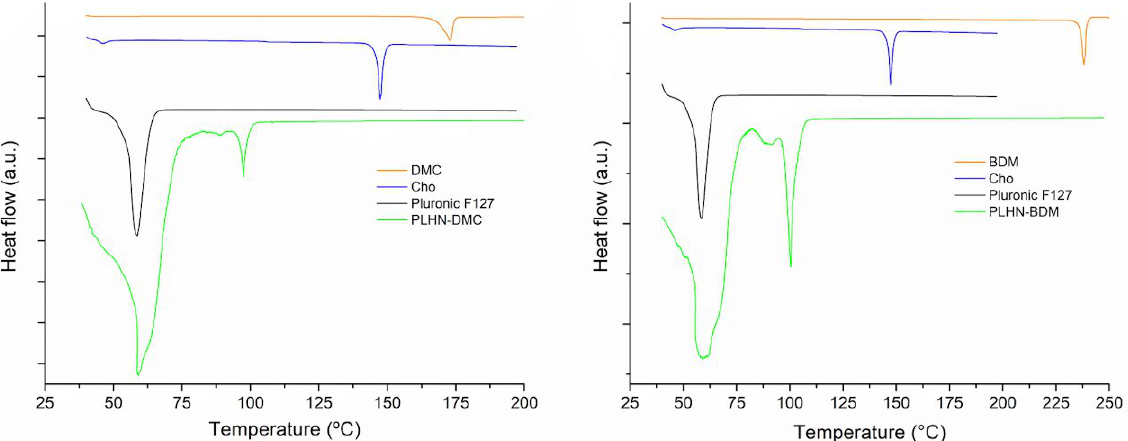
Figure 6. DSC curves of PLHNs main components and the DMC and BDM–loaded formulation.